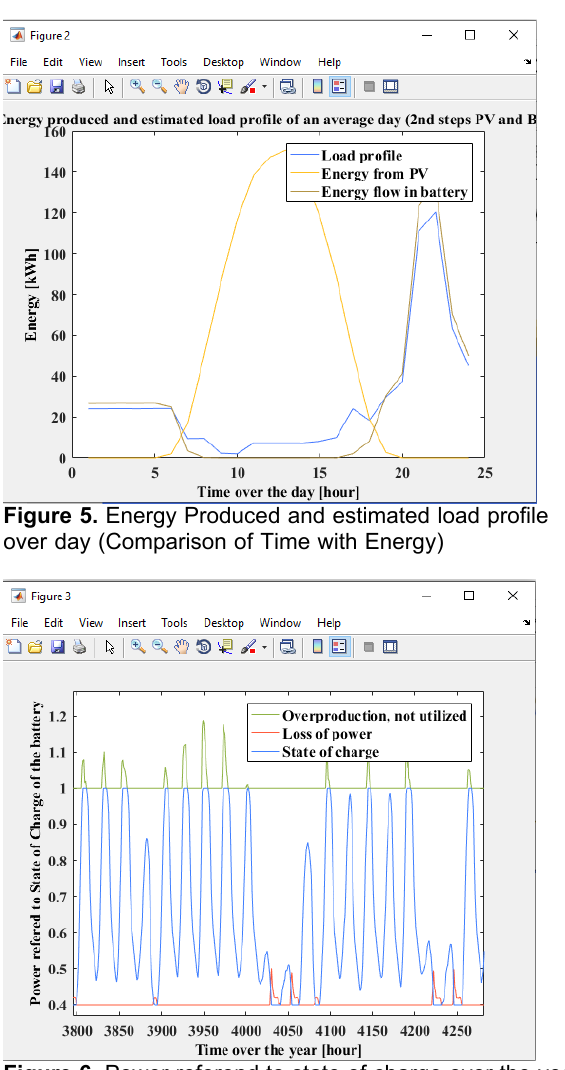
Figure 6. Power referend to state of charge over the year for overproduction, loss and state of charge